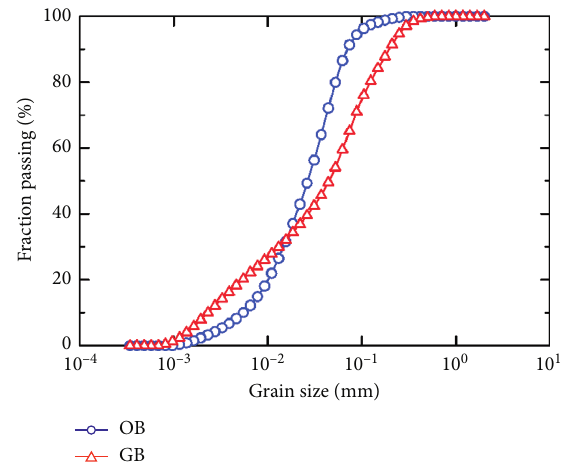
Figure 4: Grain size distribution curves of original and granular bentonites with similar grain sizes.